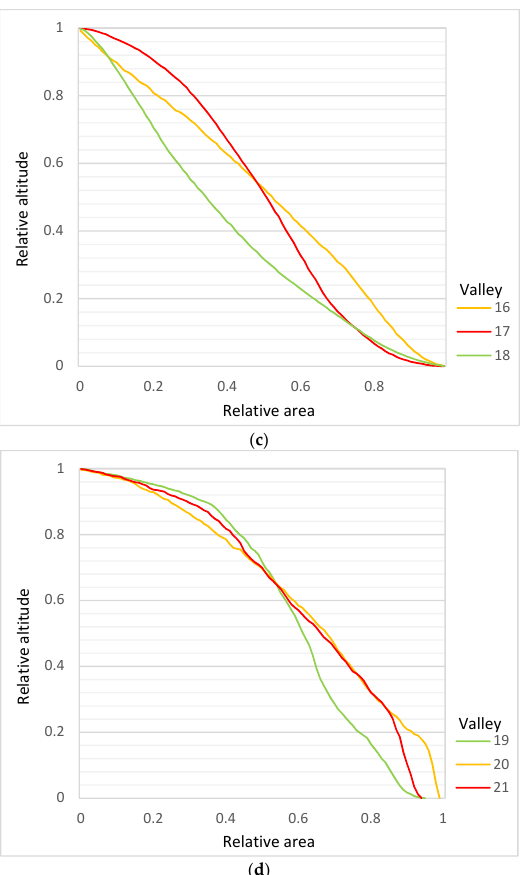
Figure 9. Hypsometric curves of the erosion-denudation valleys: ( a ) Bu ś larki test area; ( b ) Piaski Pomorskie test area; ( c ) Koprzywno test area; ( d ) Rymierowo test area. The Volume (V) parameter includes the surface of the forms and the elevation range within the forms. Based on this holistic parameter, the results are presented according to the DEM data source (Table 7). The obtained values indicate the significant diversification of the volume from 212.52 to 16,833.17 m 3 based on the field data and from 154.13 to 16,809.18 m 3 based on the LiDAR data. Within individual research sites, valleys with both small and large volumes of denuded material were identified. The highest volume values were recorded for valley 17 in the Koprzywno test area. The volume of the remaining two valleys, 16 and 18, is close to the average value, as calculated both on the basis of field data and LiDAR data. The lowest volume values were recorded for the Bu ś larki test area. Among the eight mapped valleys of this area, seven have values below the average, which allows us to state that they are the smallest forms among all the studied valleys.